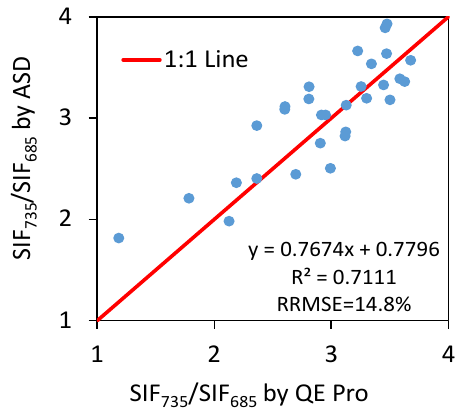
Figure 11. Comparison between retrieved ratios of SIF peak-values (SIF 735 /SIF 685 ) for data measured by QE Pro and ASD FieldSpec4